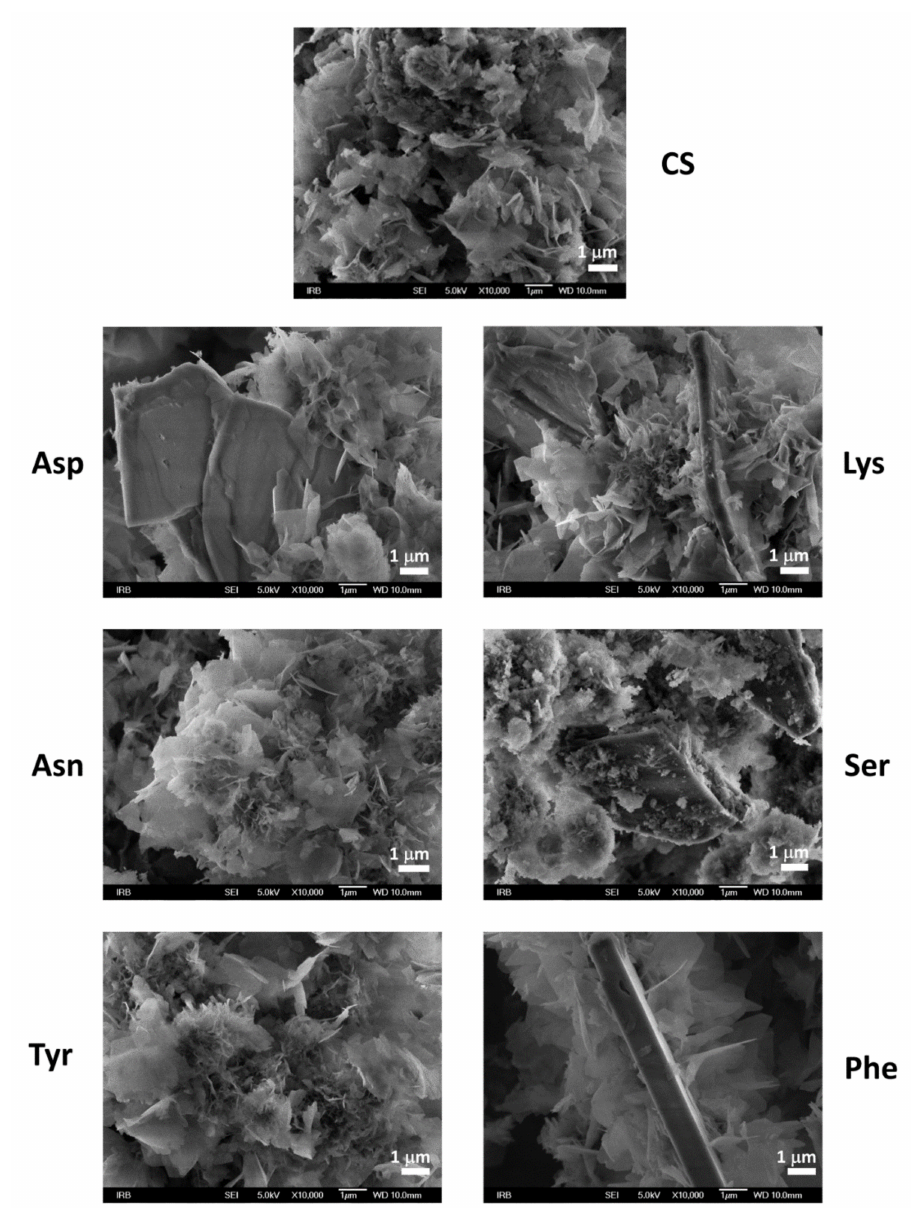
Figure 8. SEM micrographs of precipitates formed in the control system (CS) and in the presence of di ff erent amino acids after 240 min aging time in the system c (CaCl 2 ) = c (Na 2 HPO 4 ) = 4.198 mmol dm − 3 , c (NaCl) = 0.148 mol dm − 3 , m (seed DCPD) = 1 mg, γ (AA) = 10 ppm, except γ (Phe) = 5 ppm. t = 25 ◦ C, pH initial = 7.4, magnetic stirring. Asp—L-aspartic acid, Tyr—L-tyrosine,